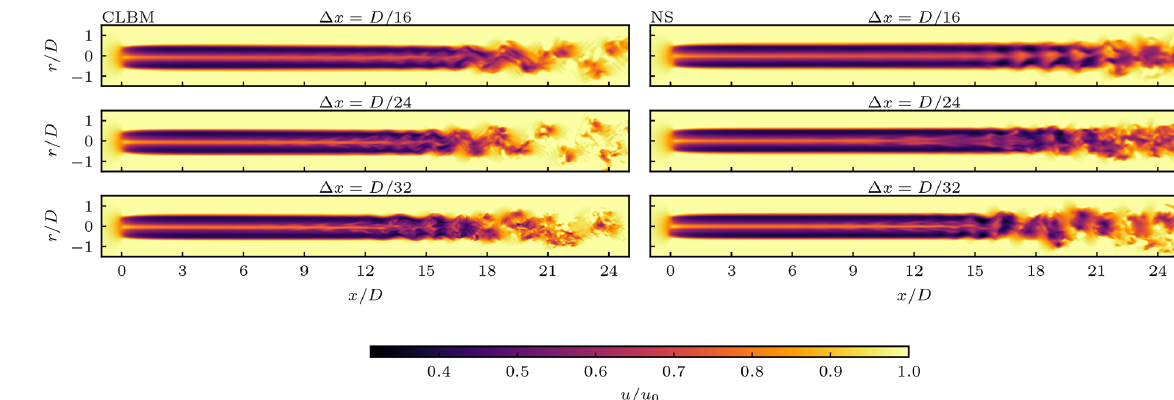
Figure 7. Contour plots of the instantaneous stream-wise velocity u in the central stream-wise plane at different spatial resolutions (top to bottom panels) with the CLBM (left panels) and NS (right panels).